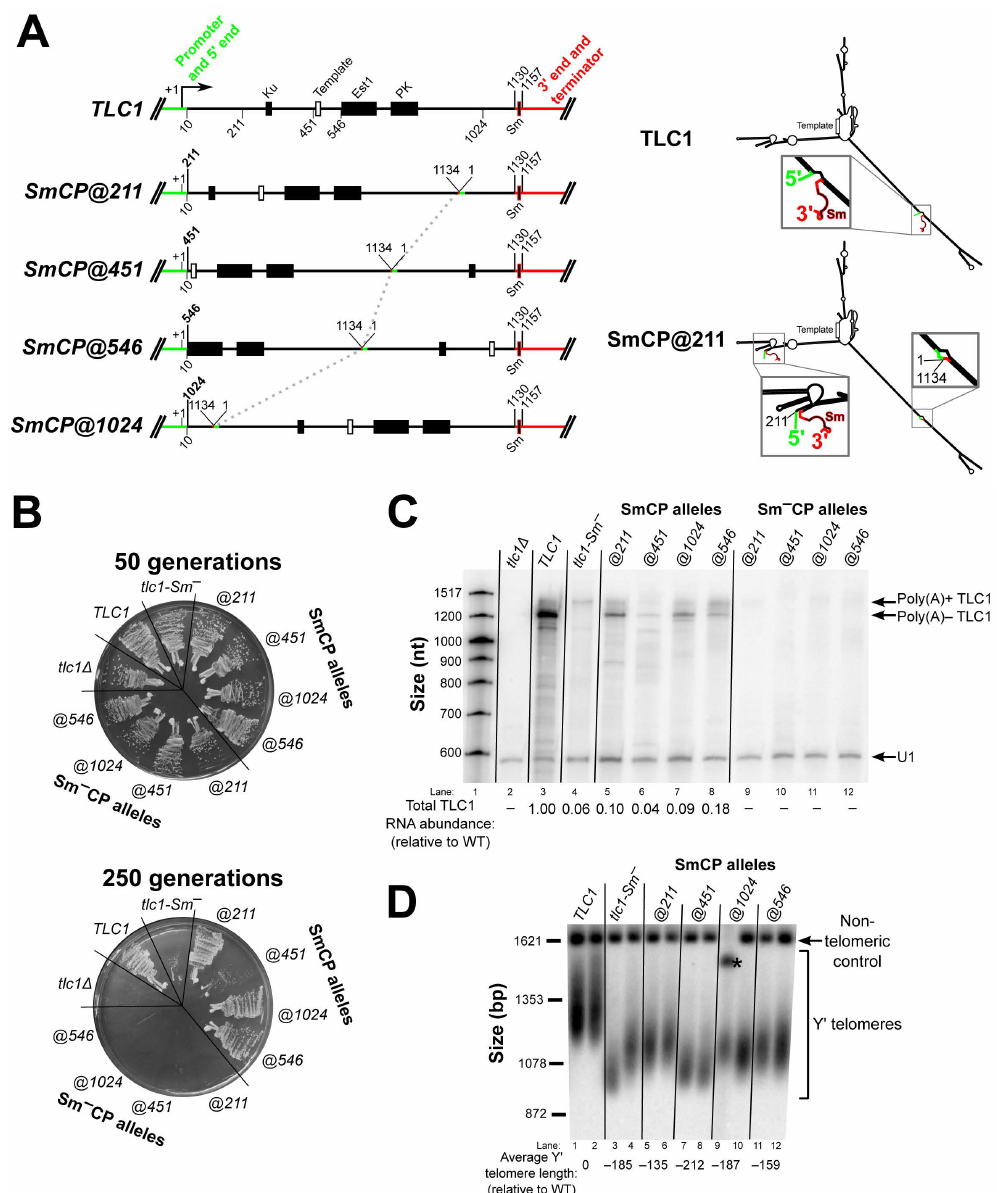
Figure 2. Sm 7 retains function in telomerase RNA when its binding site is repositioned via circular permutation. ( A ) Schematics of SmCP gene construction and expected RNA structure. The native ends of the TLC1 gene were e ff ectively sealed o ff by connecting nucleotide 1134 with nucleotide 1, thus removing the Sm site from its native position in the RNA. A dashed line connects the location of